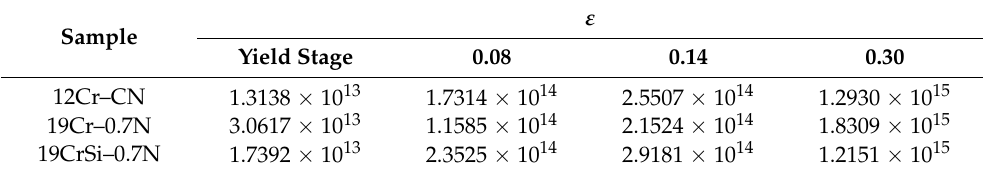
Table 4. Comparison of the rate of dislocation accumulation during deformation, m − 2 .